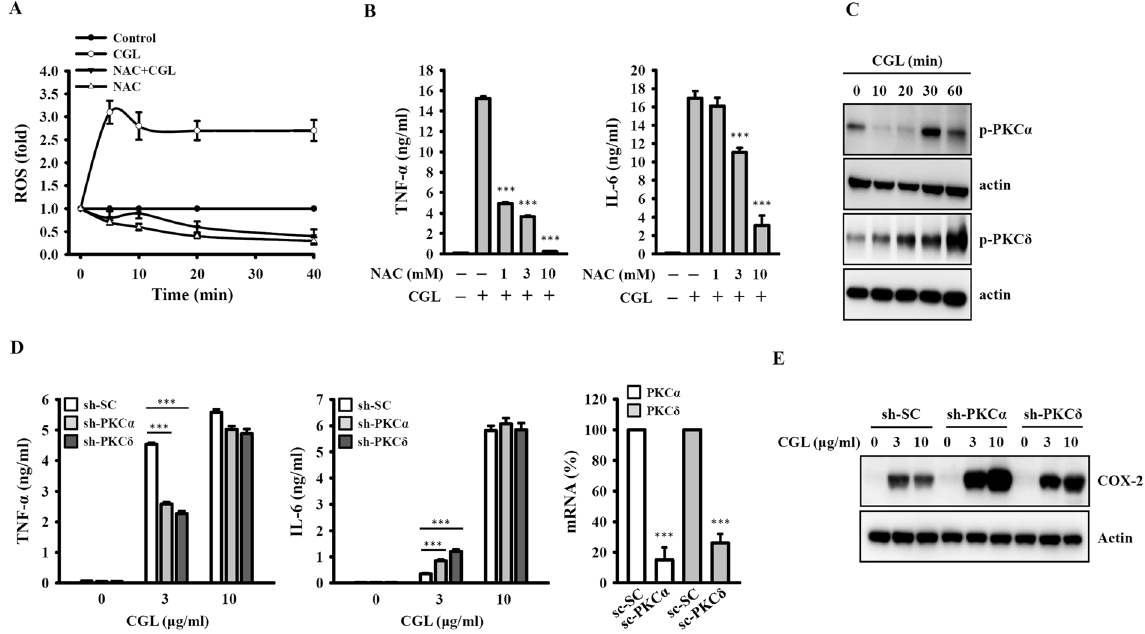
Figure 3. ROS and PKC α / δ regulate CGL-mediated TNF- α , IL-6 and COX-2 expression. ( A ) RAW264.7 macrophages were incubated for 30 min with or without NAC (10 mM) and then for 0–40 min with or without CGL (10 µ g/ml). The levels of ROS in the cells were measured by 2 ′ ,7 ′ -dichlorofluorescein diacetate. ( B ) RAW264.7 macrophages were incubated for 30 min with or without NAC (10 mM) and then for 24 h with or without CGL. The levels of TNF- α and IL-6 in the culture medium were measured by ELISA. ( C ) RAW264.7 macrophages were incubated for 0–60 min with or without CGL (10 µ g/ml). The phosphorylation levels of PKC α and PKC δ were assayed by Western blot. ( D and E ) The mRNA expression levels of PKC α and PKC δ were assayed by real-time PCR. The sh-SC, sh-PKC α and sh-PKC δ cells were incubated for 24 h with or without CGL. The levels of TNF- α and IL-6 in the culture medium were measured by ELISA ( D ), and COX-2 in the cell lysates were measured by Western blot ( E ). Western blot results are representative of those obtained in three different experiments. The ELISA data are expressed as the means ± SD of three separate experiments. *** Indicates a significant difference at the level of p < 0.001 compared to control cells. The blots in ( C ) and ( E ) were cropped; full-length blots are included in the “Supplementary